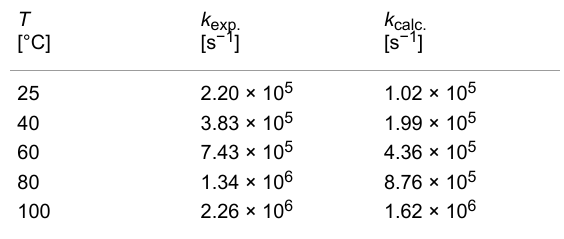
Table 2: Rate constants of the 5- exo cyclization of the hexenyl radical in benzene at different temperatures calculated at the